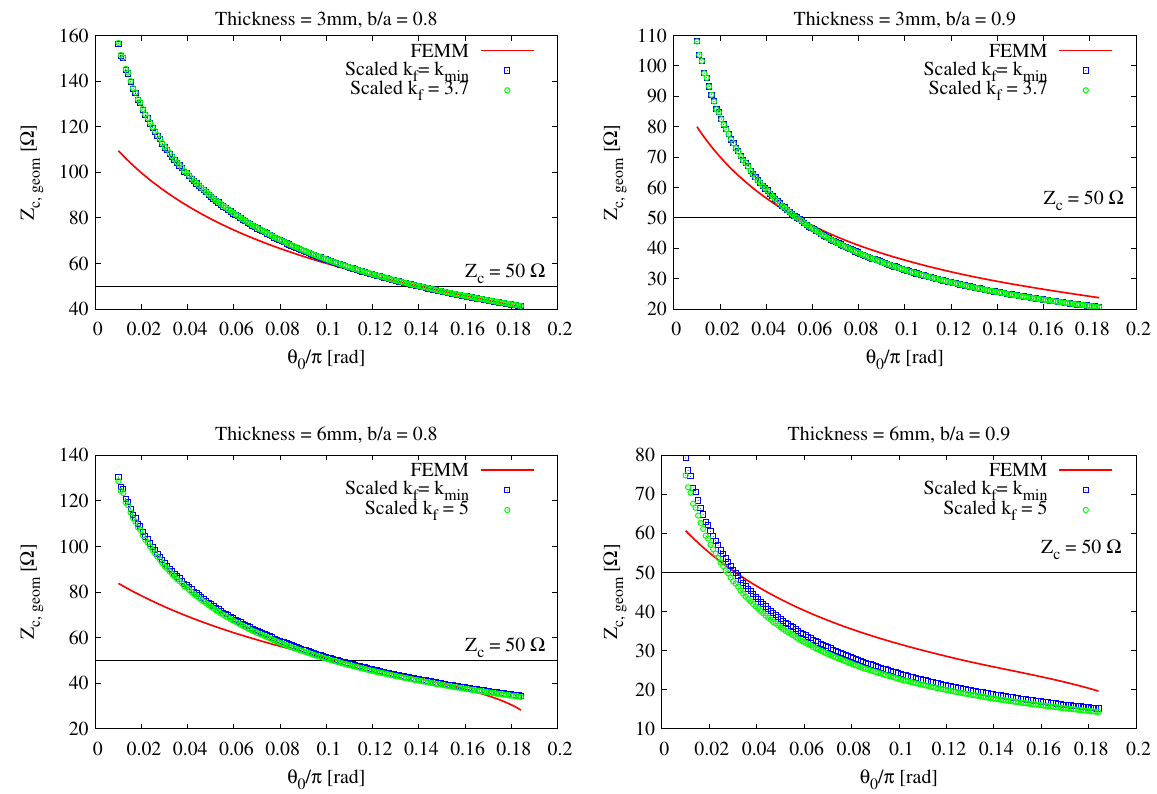
FIG. 16. Quadrupoles: Scaled impedance as a function of θ 0 with for different thickness plates. Top row with t ¼ 3 mm; left plot b=a ¼ 0 . 8 , right plot b=a ¼ 0 . 9 . Bottom row with t ¼ 6 mm: left plot, b=a ¼ 0 . 8 , right plot b=a ¼ 0 . 9